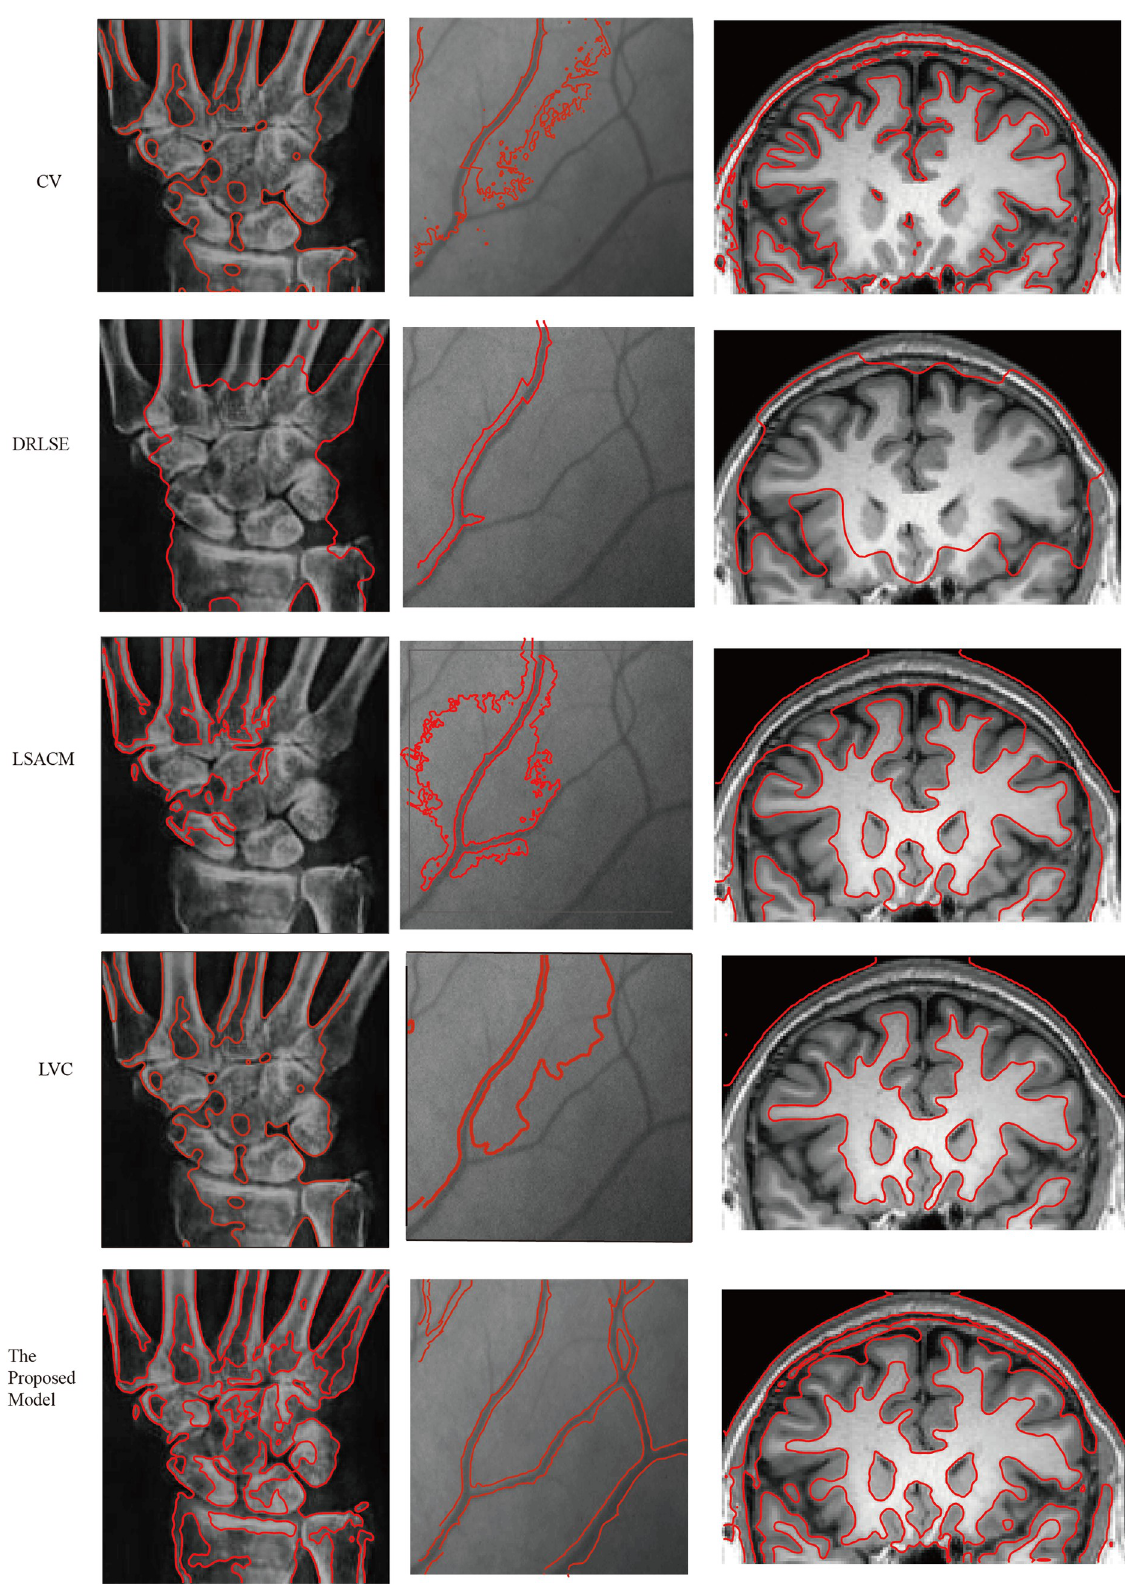
Fig 2. Segmentation results of the proposed model and CV, DRLSE, LSACM, LVC models. https://doi.org/10.1371/journal.pone.0255948.g002 PLOS ONE | https://doi.org/10.1371/journal.pone.0255948 August 19,